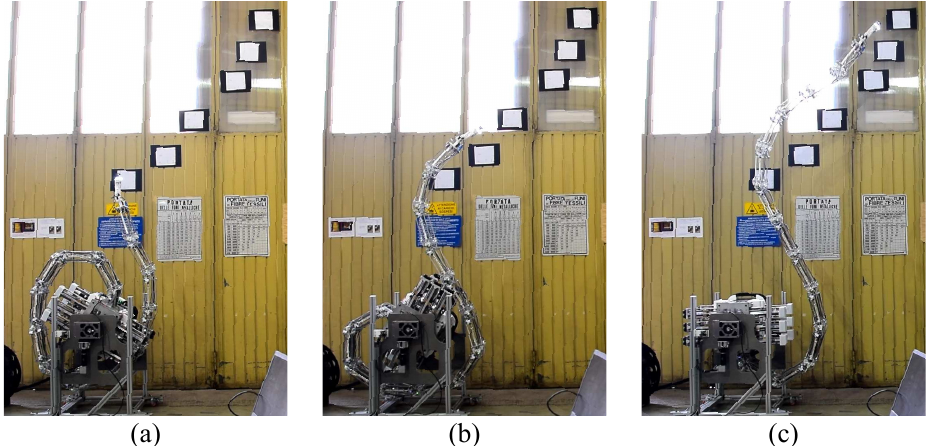
Figure 13. Pictures of SLIM performing the inspection task. ( a ) shows SLIM at P 1 ; ( b ) shows SLIM at P 2 ; ( c ) shows SLIM at P 4